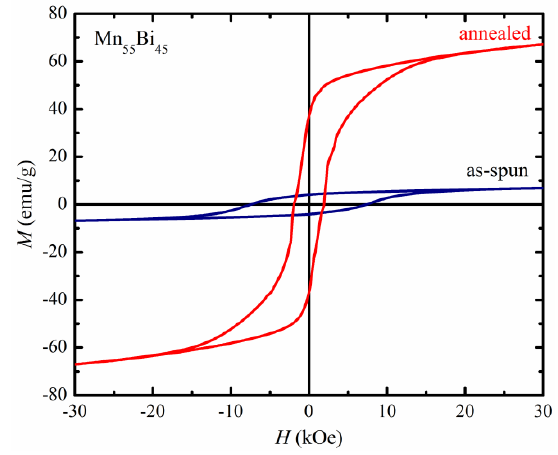
Figure 2. Hysteresis loops of Mn 55 Bi 45 powders before and annealed at 573 K for 30 min.